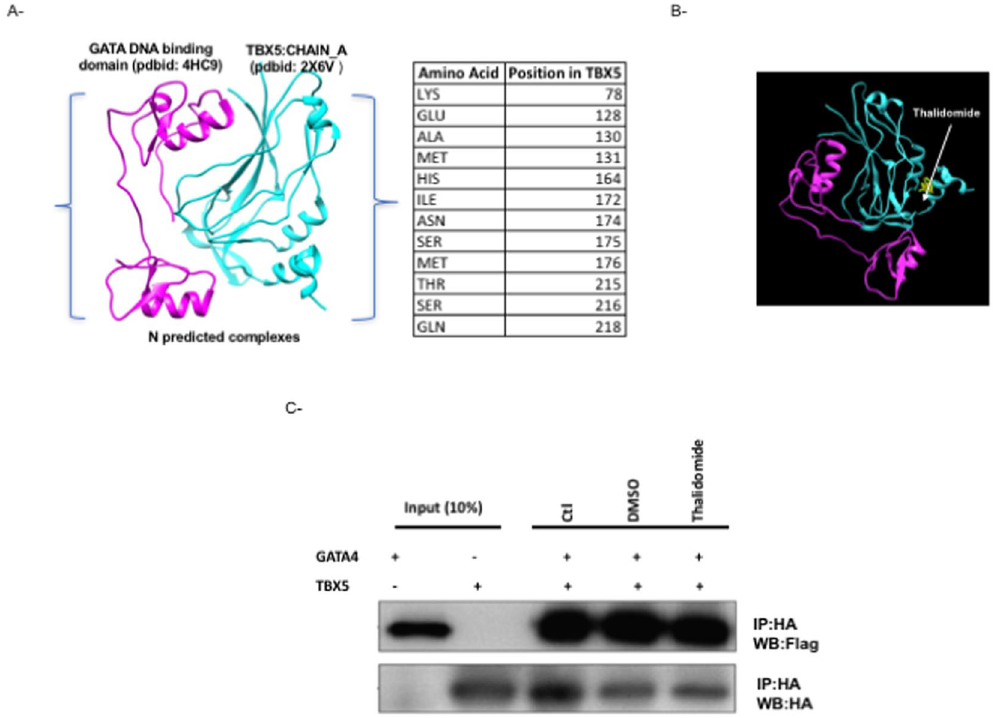
Figure 3. GATA4/TBX5 interaction is not affected by Thalidomide. Protein-protein docking interface between TBX5 and GATA4 modeled DNA binding domain as retrieved from PDB. Only Residues of TBX5 within 5 angstroms of this interaction are shown ( A ). The position of thalidomide in the context of the predicted TBX5- GATA4 interaction is clearly away from the interface region ( B ): TBX5 (cyan) and GATA4 (magenta). The physical interaction between both proteins was assessed by co-immunoprecipitation in the presence or absence ( − ) of either 4 µ M thalidomide or DMSO ( C ). Ten times the quantity of proteins loaded for western blot was used for immune-precipitation. Nuclear lysates for both GATA4 and TBX5 were immune-precipitated with anti‐HA antibody and GATA4 proteins were visualized by western blot with an anti‐flag antibody. Membrane stripping and subsequent western blot analysis was performed with anti‐HA antibody in order to detect TBX5 proteins. Quantitation of the bands didn’t show any significant change. (Ctr: control, WB: Western-Blot, IP: